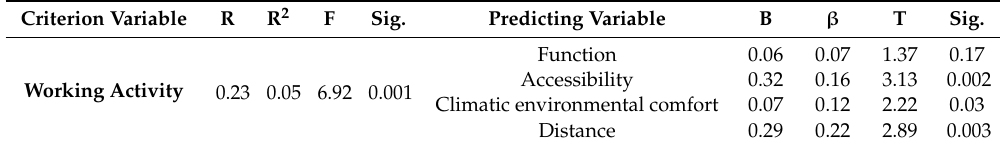
Table 6. Results of regression analysis for predicting essential and working activity.